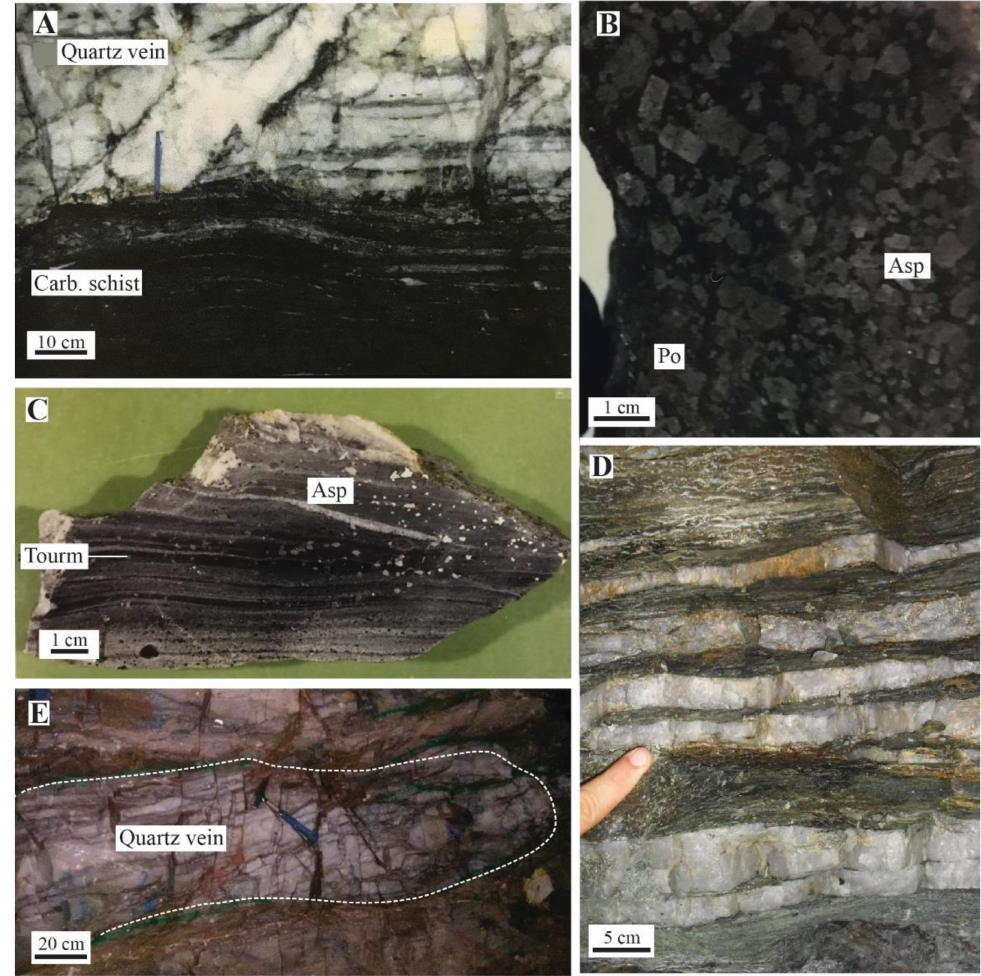
Figure 4. Hand samples showing mineralization styles in orogenic gold deposits of the GAB. ( A ) Vein-hosted [118] and ( B ) massive sulfide [119] mineralization in carbonaceous schist of the Mina III orebody; ( C ) disseminated sulphides in the Maria L á zara deposit. Note Asp overprints Wm-Tour hydrothermal assemblage [14]; ( D ) laminated quartz veins and gold disseminated in Py-Asp-Po from the Og ó deposit (Pilar de Goi á s) [120], and ( E ) vein-hosted mineralization controlled by